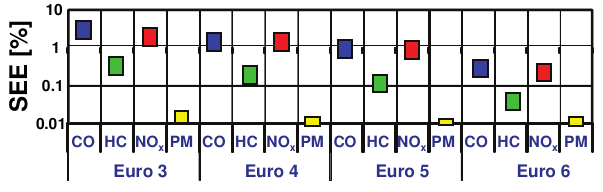
Fig. 21. Diesel PC – standardization of exhaust emission